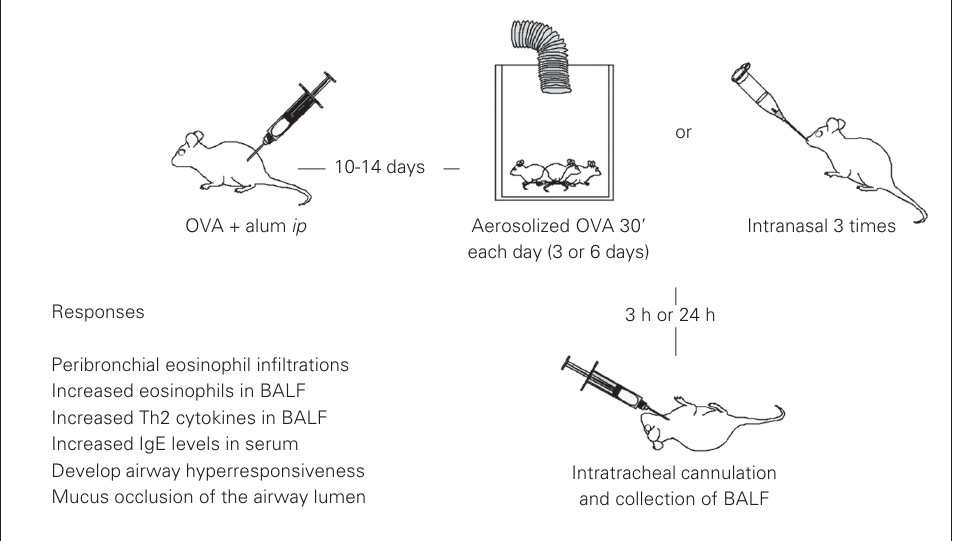
Figure 1. Murine model of asthma. Mice are immunized in- traperitoneally ( ip ) with ovalbu- min (OVA) plus alum as adjuvant. The antigen challenge is per- formed at least 14 days later, either with aerosolized OVA once a day for several consecu- tive days or intranasally on alter- nate days. Three or twenty-four hours after that in vivo and in vitro data are collected. BALF, bronchoalveolar lavage